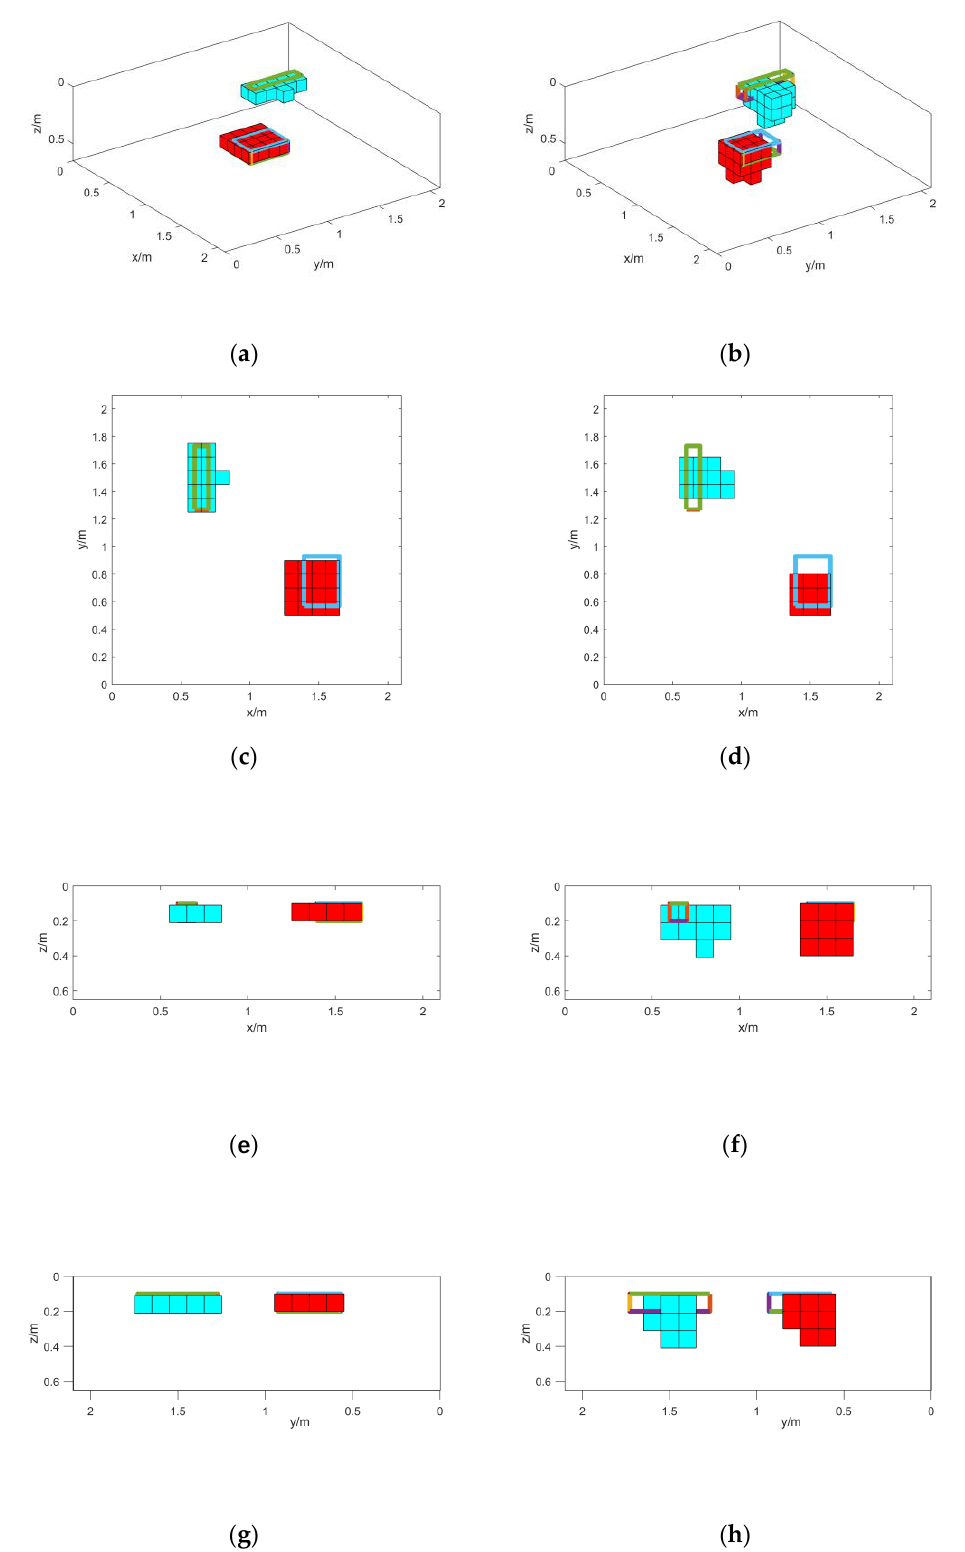
Figure 16. Inversion results: ( a ) Method 1 inversion results; ( b ) method 2 inversion results; ( c ) top view of method 1 inversion results; ( d ) top view of method 2 inversion results. ( e ) main view of method 1 inversion results; ( f ) main view of method 2 inversion results; ( g ) left view of method 1 inversion results; ( h ) left view of method 2 inversion results.